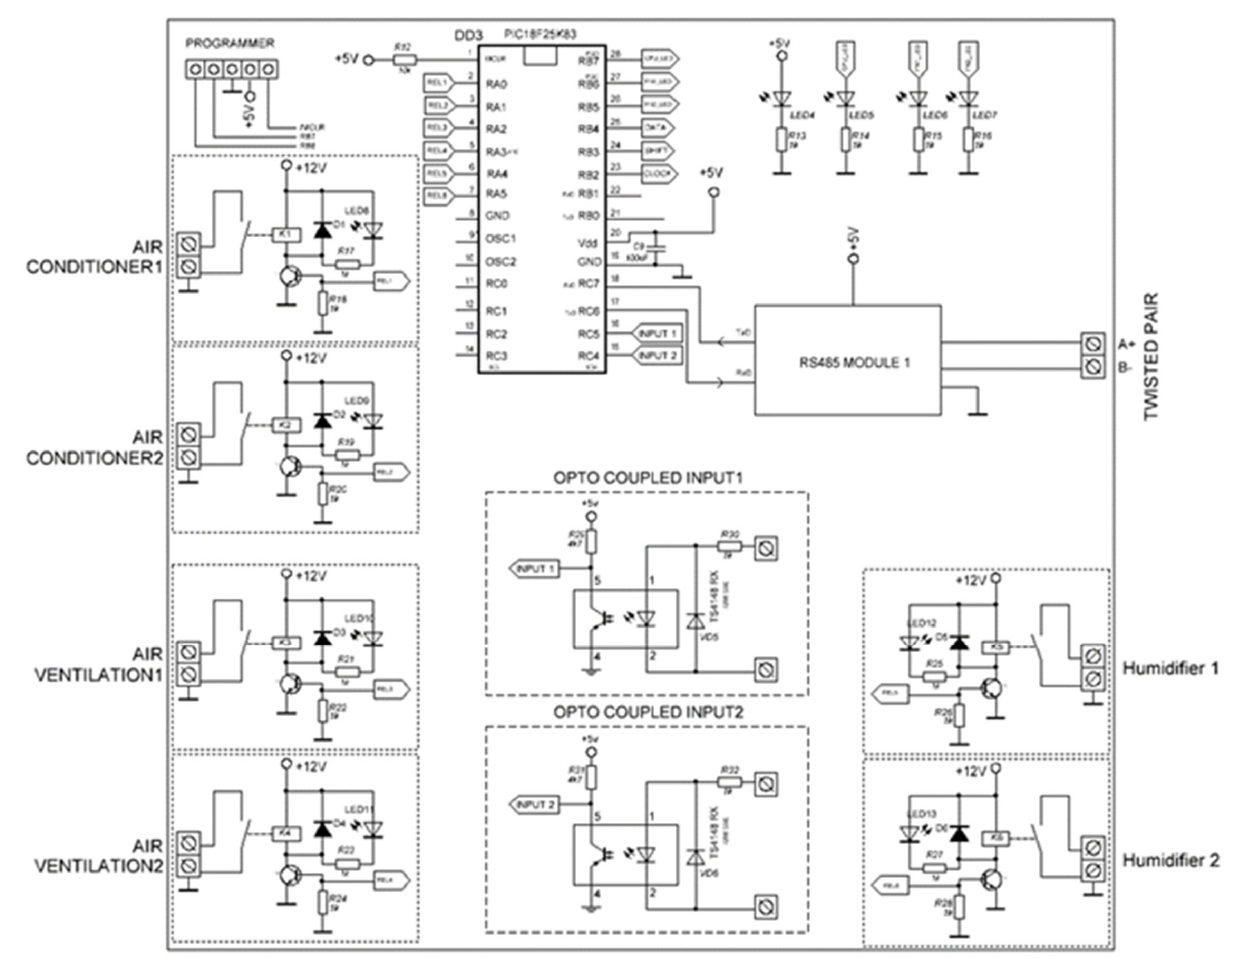
Figure 2. Main PLC electronic circuit.